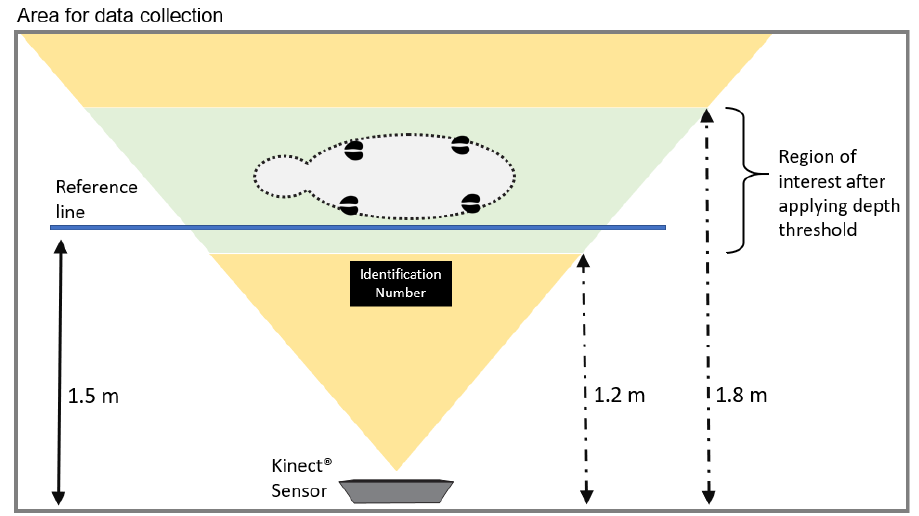
Figure 2. Configuration of the area for data